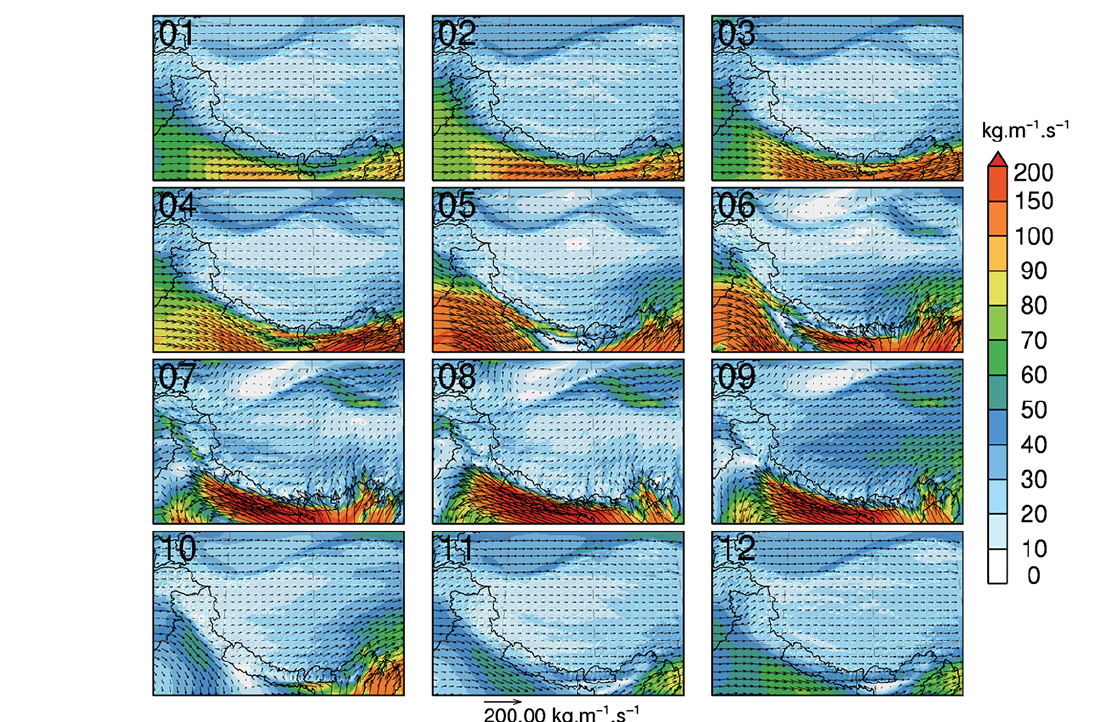
Figure 4. Decadal average of the vertically integrated water vapour flux (kgm − 1 s − 1 ) in every month for HAR10. Colour shading denotes strength of water vapour flux, arrows (plotted every eighth grid point) indicate transport direction (length of arrows is proportional to flux strength up to 200kgm − 1 s − 1 and is constant afterwards for more readability).